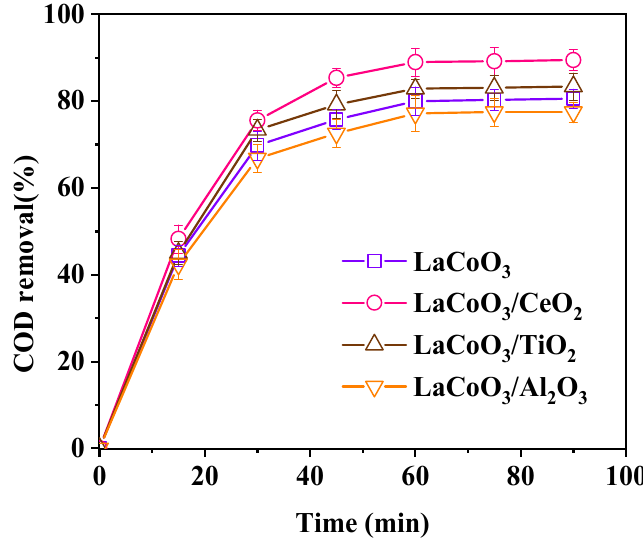
Figure 2. Effect of catalyst support on catalytic effect. (Catalyst preparation conditions: calcination temperature = 800 °C, calcination time = 8 h; Reaction conditions: LaCoO 3 /CeO 2 = 0.8 g/L, H 2 O 2 = 40 mM, 120 °C, 1 MPa, 60 min).